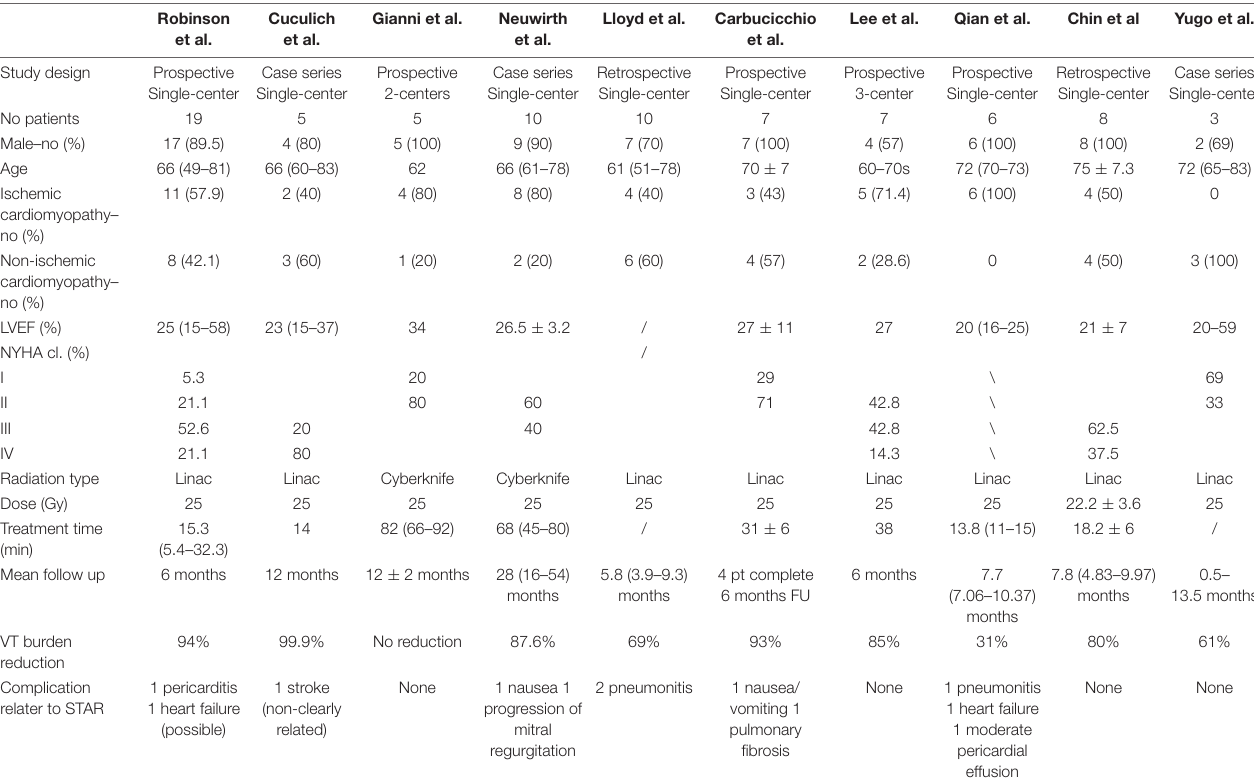
TABLE 1 | Characteristics of the studies included in the